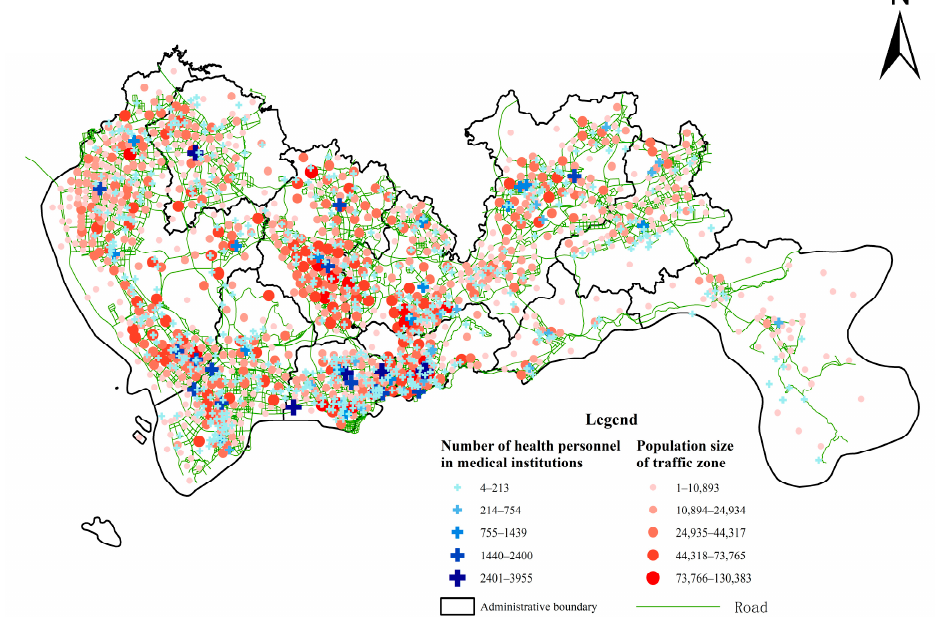
Figure 2. Distribution of medical resources and TAZs in Shenzhen in 2018.